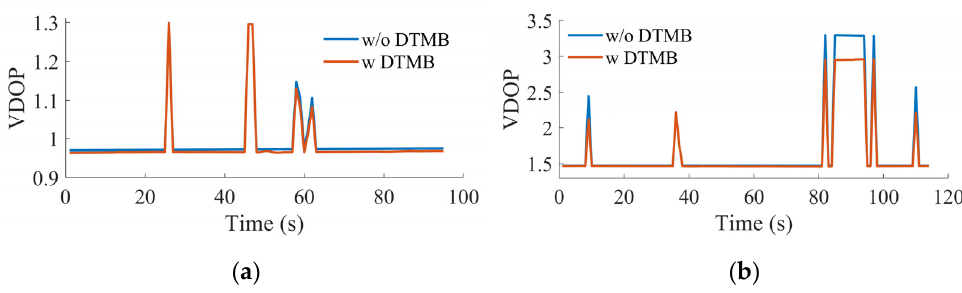
Figure 15. VDOP results in dynamic scenario of Wuhan. ( a ) Clockwise. ( b ) Counter-clockwise.